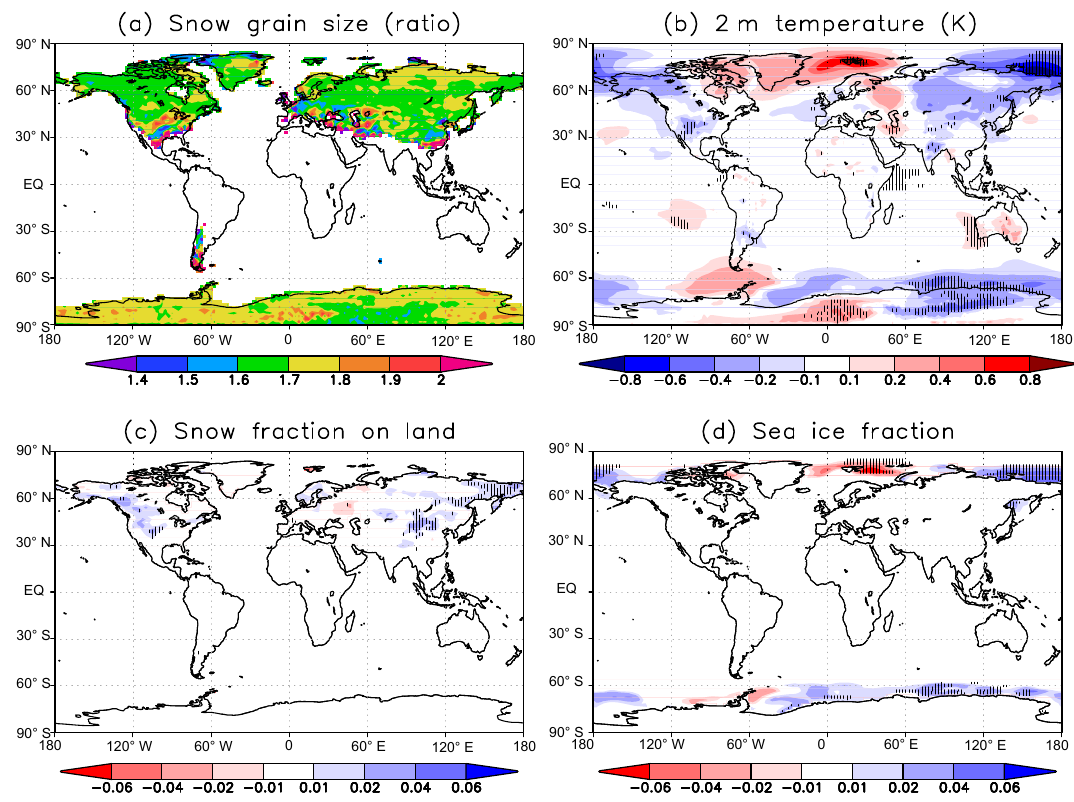
Figure 11. Annual-mean differences between the TUNED and SPH experiments: (a) the ratio of snow grain effective radius in TUNED to that in SPH in the uppermost snow layer on land, (b) the difference in 2m air temperature (K), (c) the difference in snow fraction on land, and (d) the difference in sea ice fraction. In (b)–(d) , differences significant at the 5% level are indicated with vertical